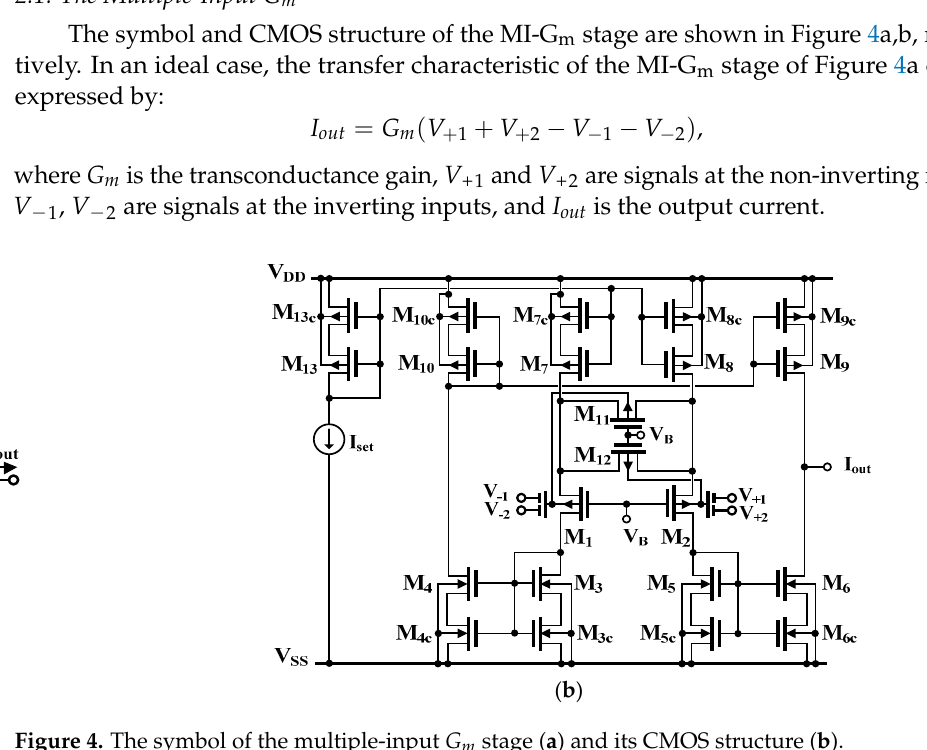
m stage ( a ) and its CMOS structure ( b